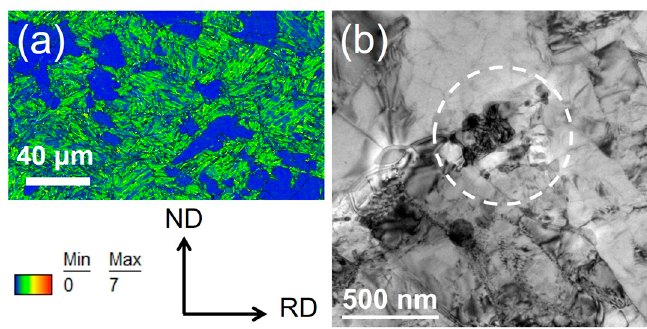
Figure 11. High-angle annular dark-field (HAADF) image showing microstructure in ( a ) S690Q steel and ( b ) NiCu steel after a 720 °C tempering for 1 h.